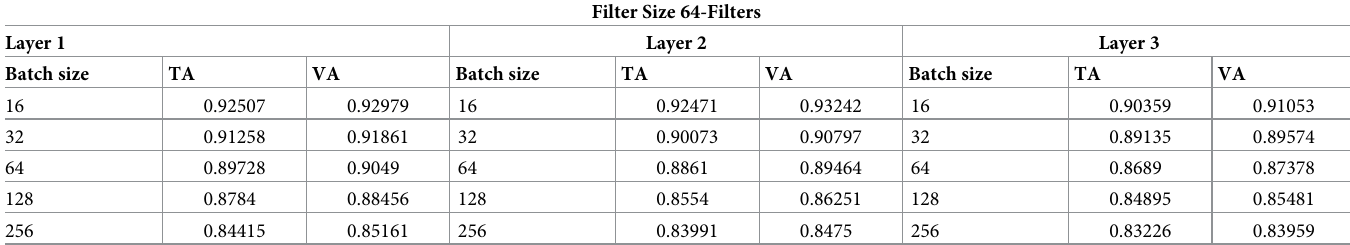
Table 5. Experimentation results of LSTM with